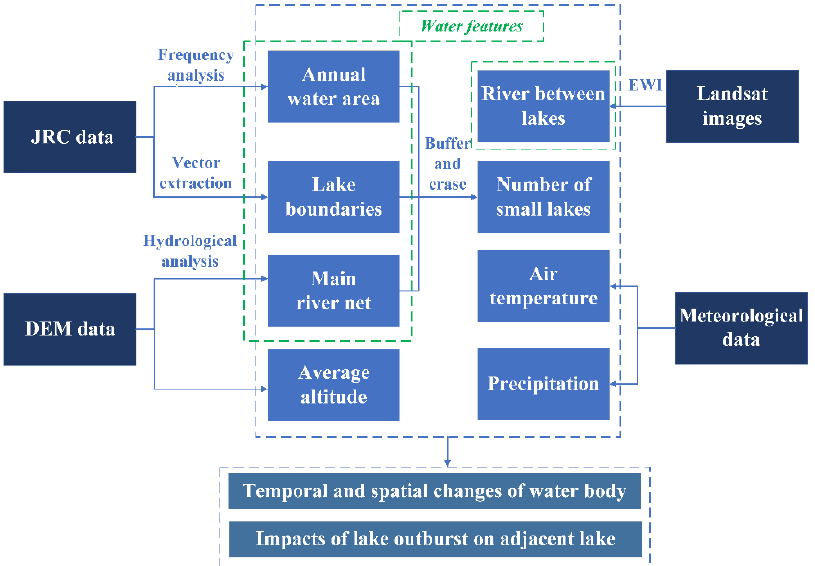
Figure 3. Flowchart of the acquisition of water body changes and impacts of lake outburst on adjacent lake on ZSLB.